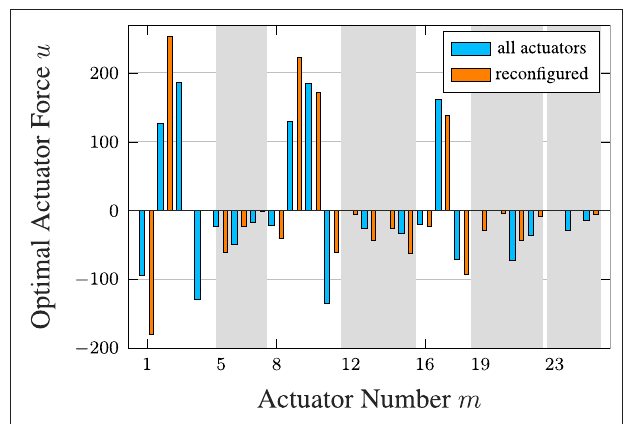
FIGURE 12 | Optimal actuator forces over the actuator number for all actuators available (blue) and for the reduced actuator set (orange). Serial actuators have a gray